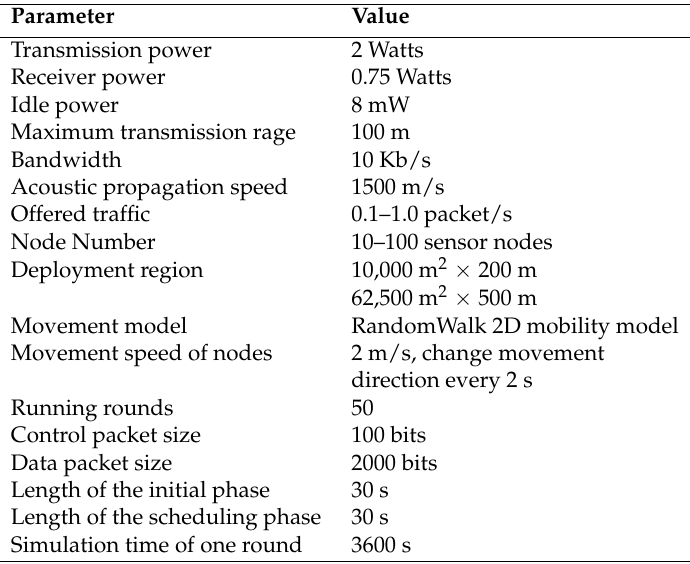
Table 2. Simulation